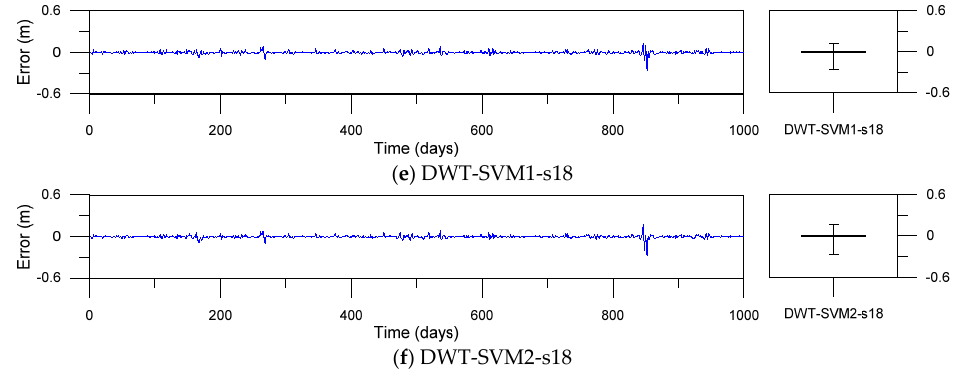
Figure 13. Error time series plots and error boxplots for the DWT-based models.